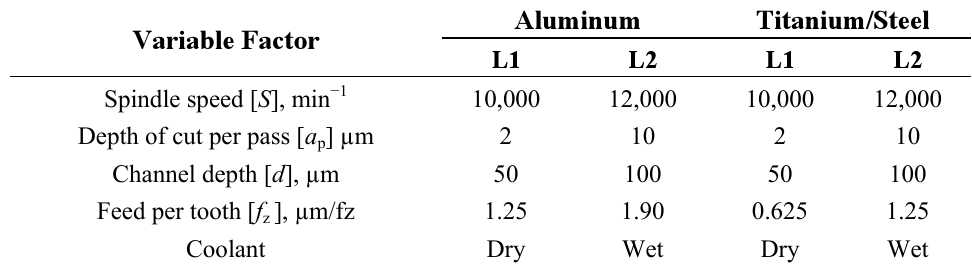
Table 1. Variable factors and levels of milling